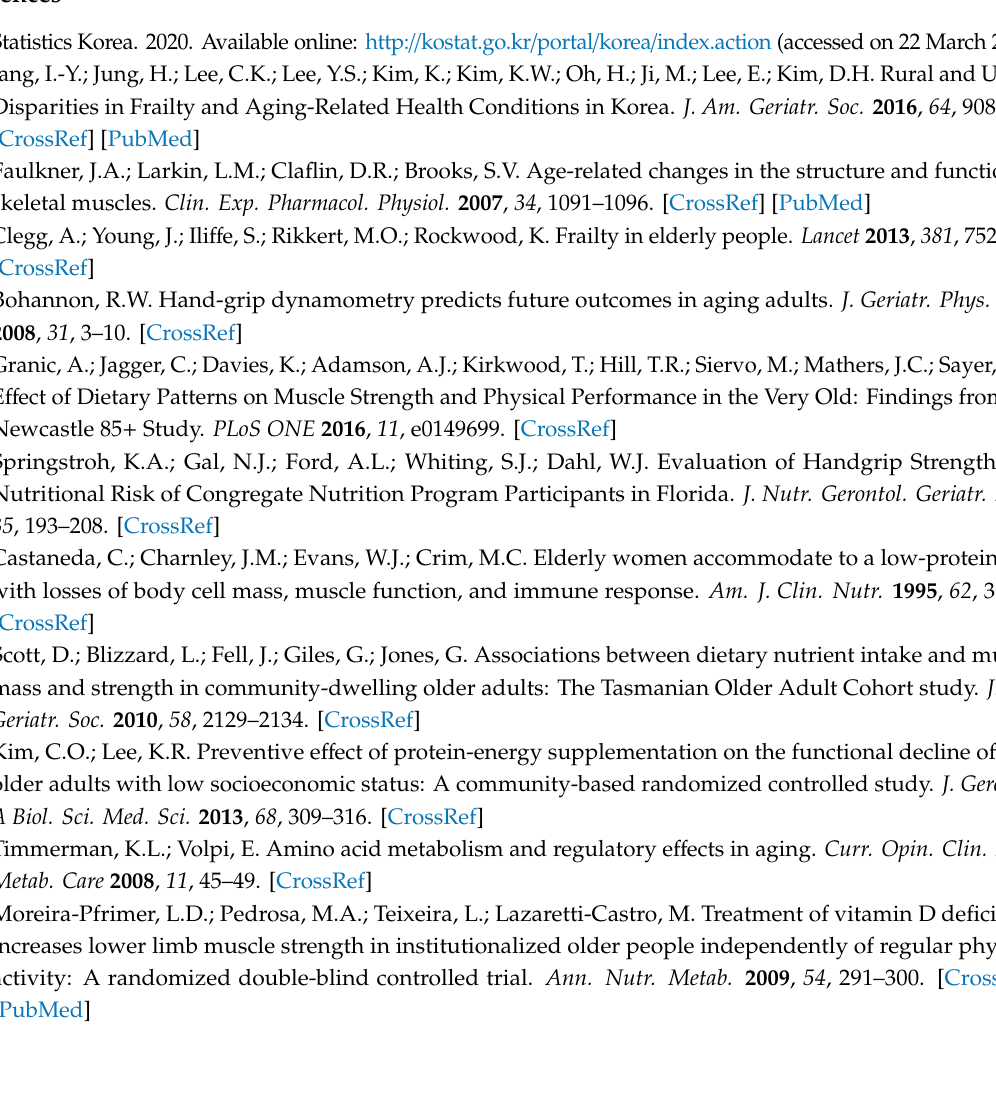
Table S1: Food groups and items used in the dietary pattern analysis, Table S2: Intakes of food groups (g / day or mL / day § ) by